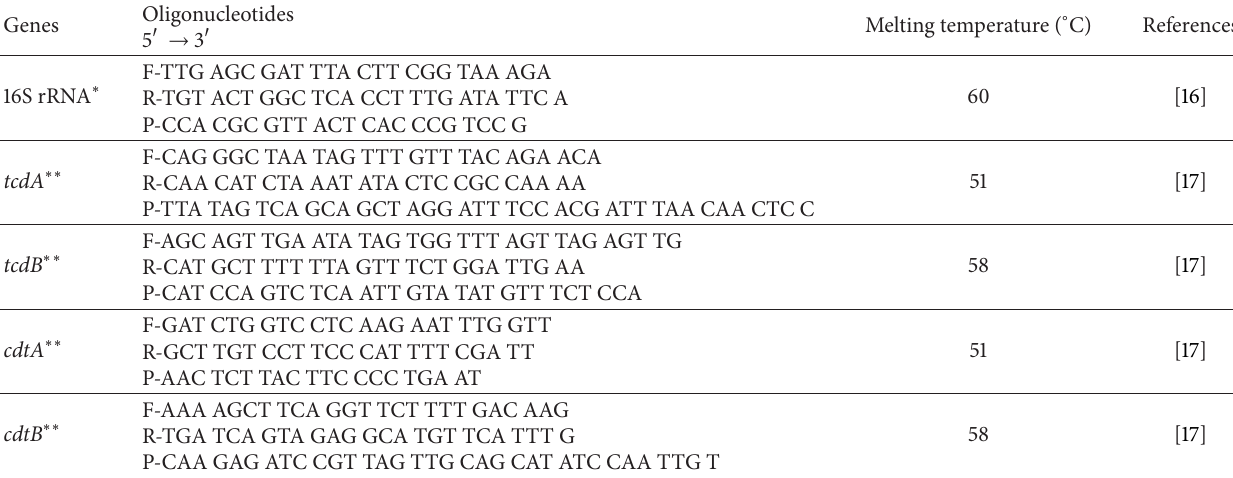
Table 1: Genes and primer/probe sets used to detect C. difficile and genes encoding toxins. Oligonucleotides Genes